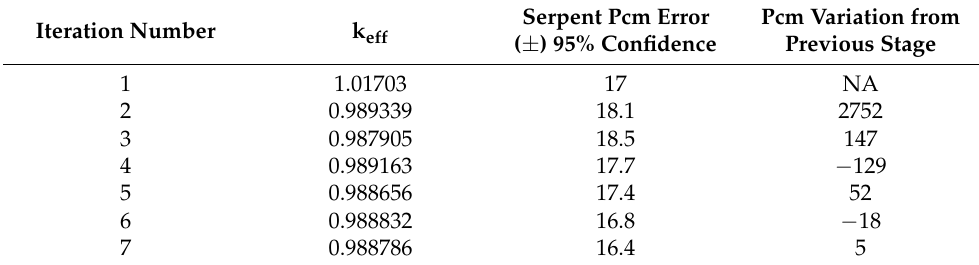
Table 6. Serpent/CTF variations between iteration